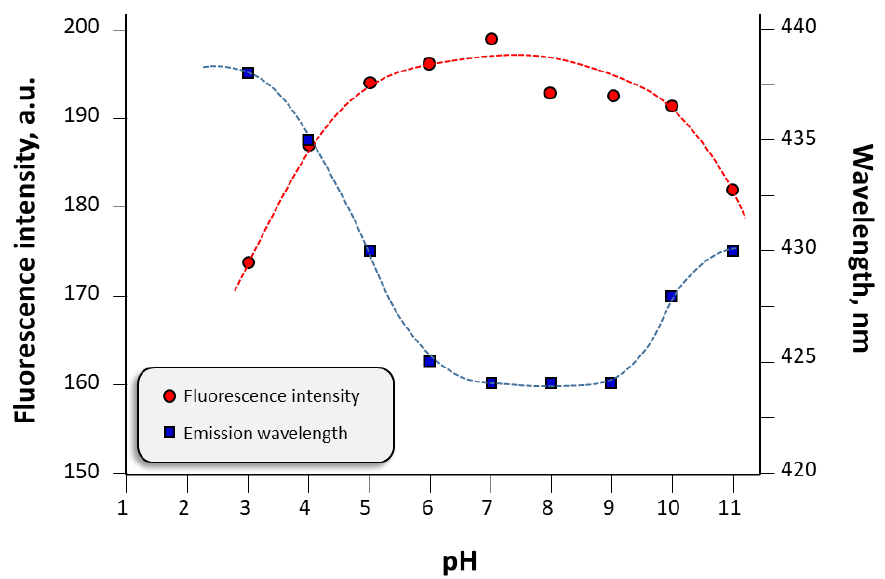
Figure 4. Emission wavelength and intensity of TCDs at different pH values.